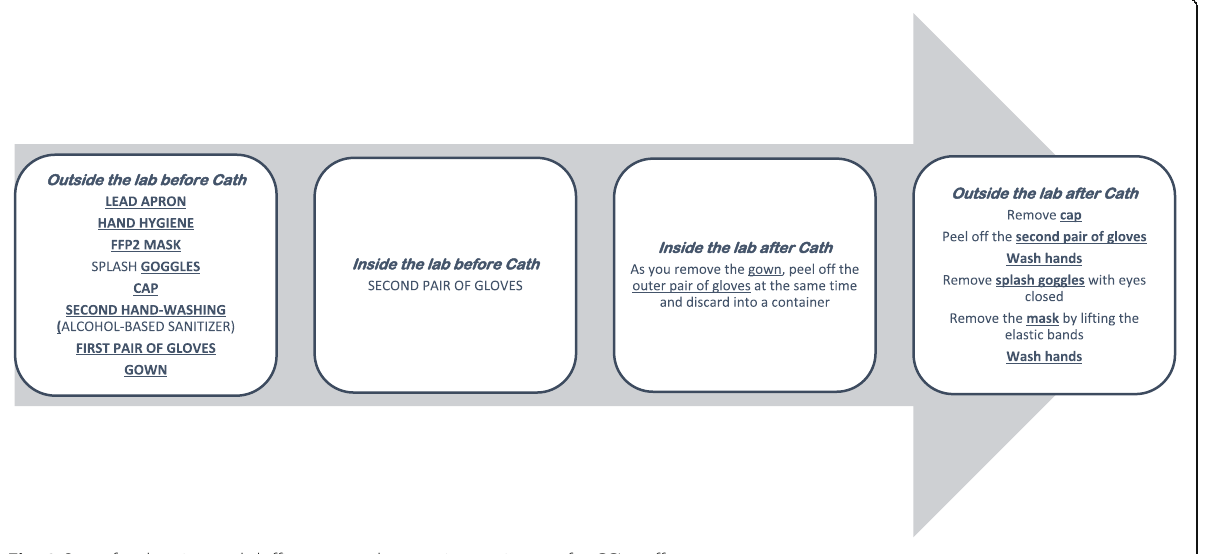
Fig. 3 Steps for donning and doffing personal protective equipment for CCL staff